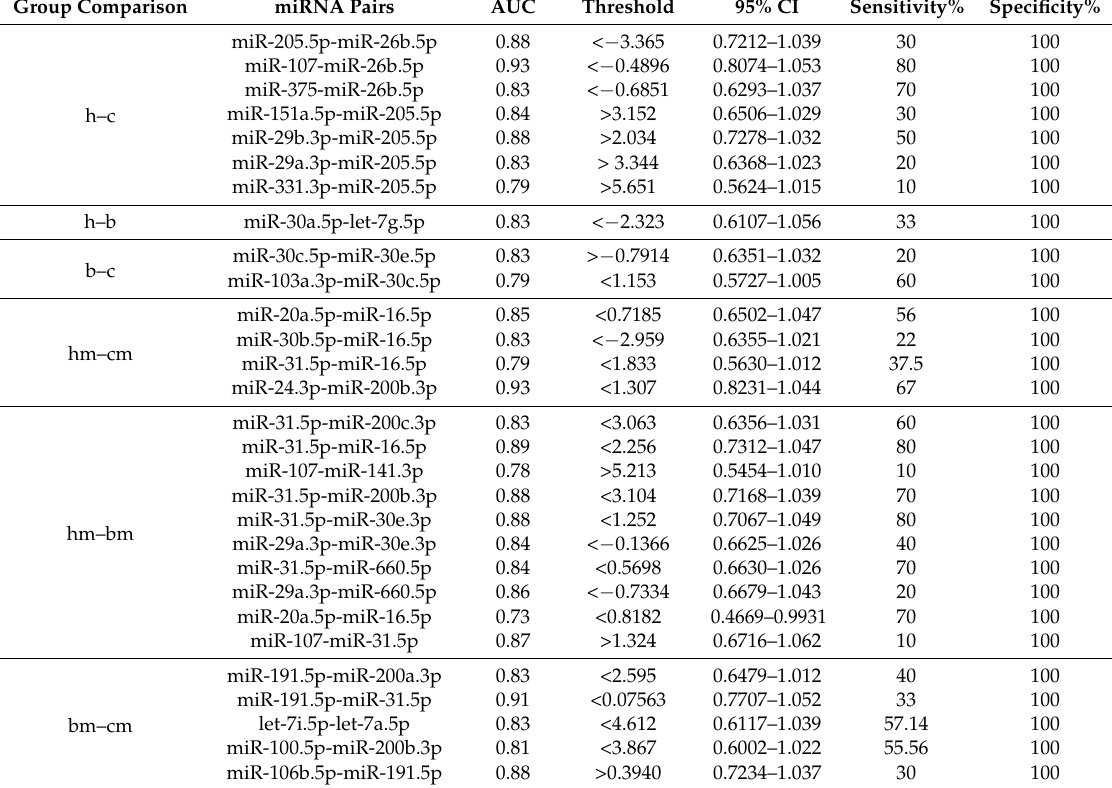
Table 4. Diagnostic performance of miRNA pairs in urine supernatant and urine